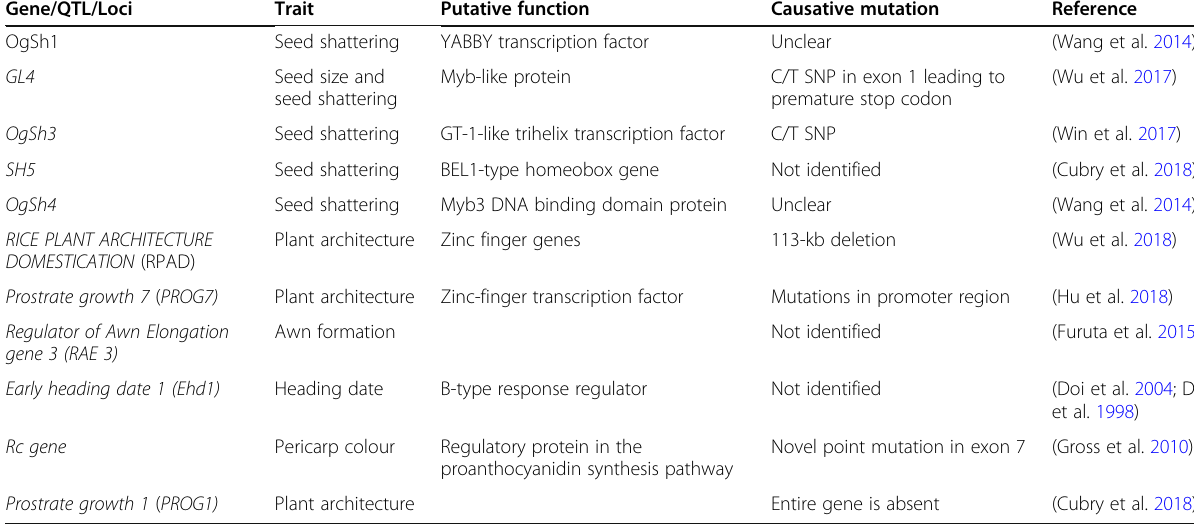
Table 1 Key domestication genes in African rice